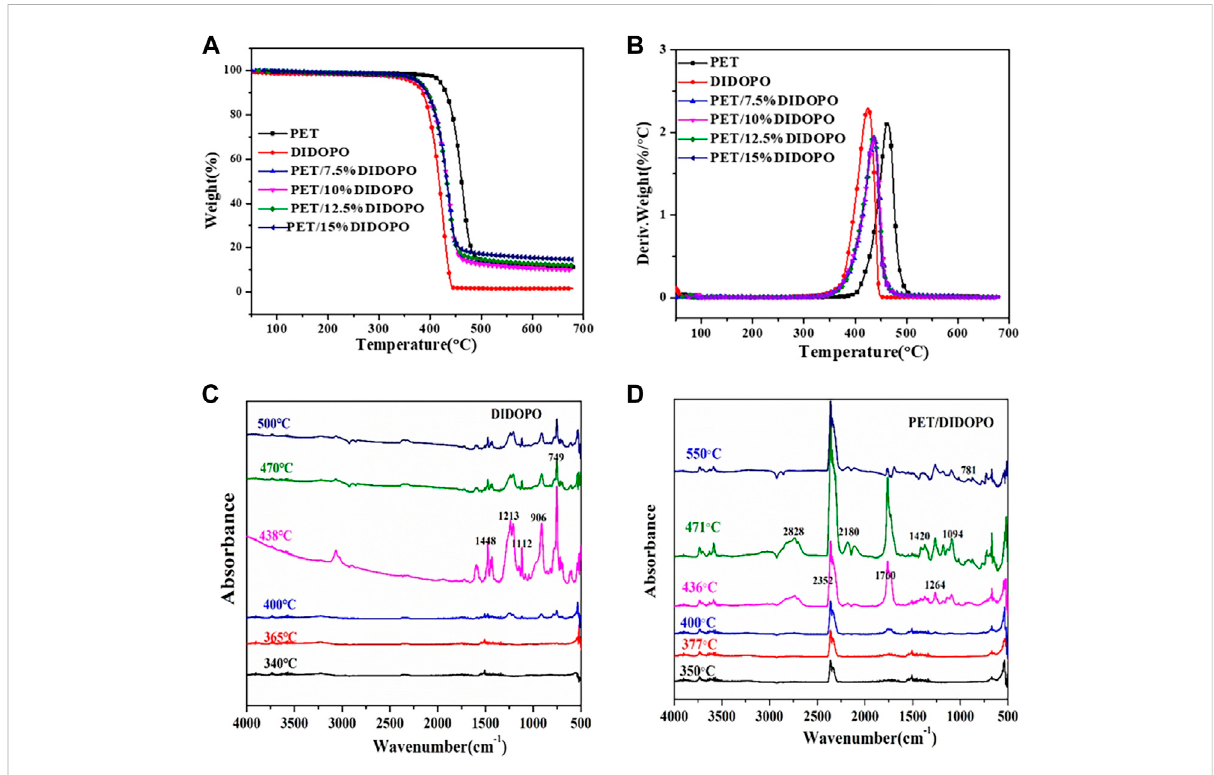
FIGURE 2 TG (A) and DTG (B) curves of PET and PET/DIDOPO composites of PET/DIDOPO composites and TG-IR of DIDOPO (C) and PET/15wt% DIDOPO fl ame retardant composites (D) at different temperatures spectrum.